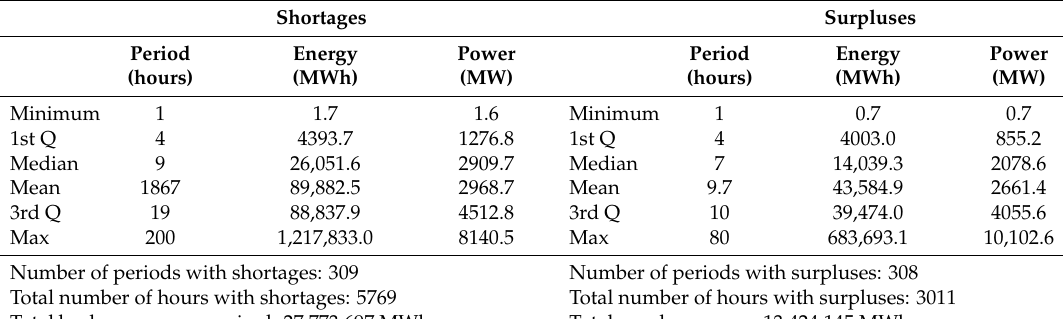
Table 3. The descriptive statistics of shortages and surpluses intervals: For each interval, its length in hours, its total energy in MWh and its average power in MW have been computed. Source: authors based on the results from the optimization